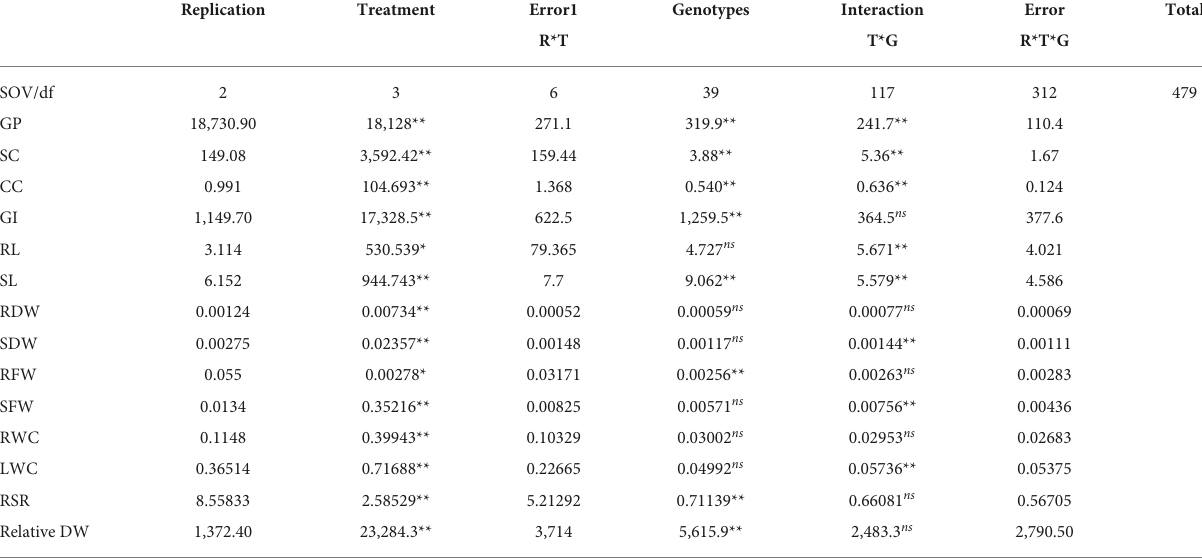
TABLE 1 Analysis of variance (ANOVA) mean squares of 40 genotypes at the seedling stage under normal and salinity stress conditions. Replication